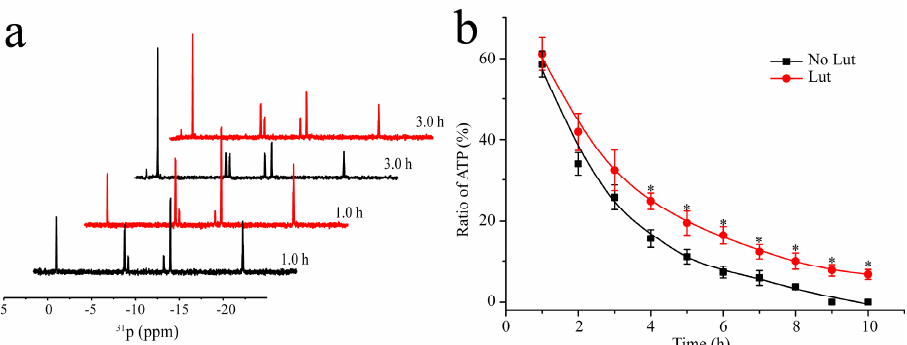
Figure 2. Inhibition of the autophosphorylation activity of HK853 cp by luteolin. ( a ) 31 P-NMR spectra of the reaction between HK853 cp and ATP (reaction conditions: 20 mM Tris, 50 mM KCl, 10 mM MgCl 2 , 8 mM ATP, 0.4 mM HK853 cp , and 0.8 mM Lut (in Lut group) with 10% D 2 O, pH 8.0) reaction time of 1 h and 3 h). The reaction groups in the absence of luteolin are shown in black, while the reaction groups in the presence of luteolin are in red; ( b ) the ratio of ATP in the reaction mixture obtained by the integration of 31 P-NMR signals. The no-luteolin group was labeled by ■ . The luteolin containing group was labeled by ● . ( n = 3, * p < 0.01, compared to no-luteolin group).